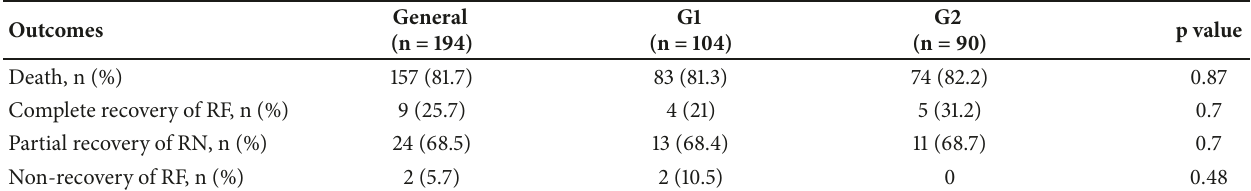
Table 3: Main outcomes of patients with AKI treated with PHD according to the duration of the PHD sessions.